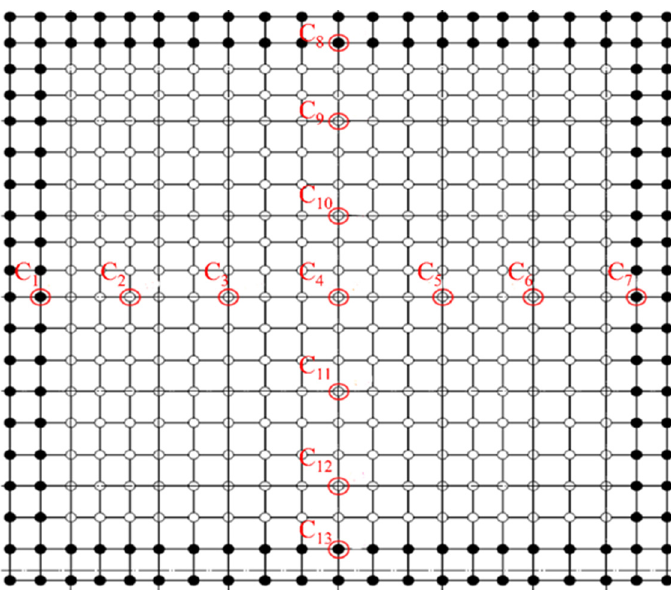
Figure 9. Manual survey control points.